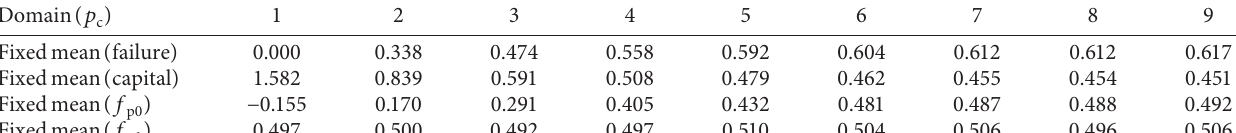
obtained from Figure c